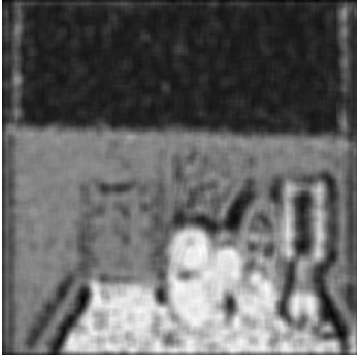
Fig. 8 The estimated depth map of the reconstructed data